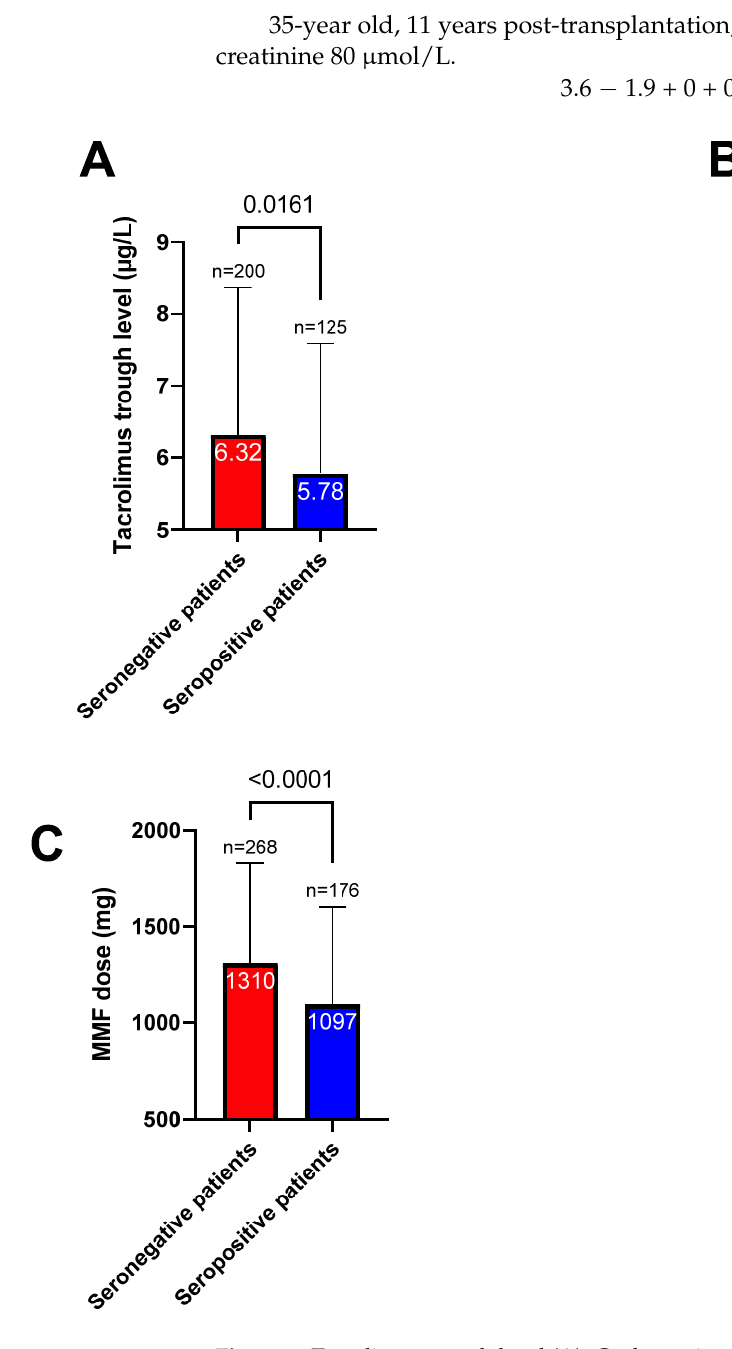
Figure 4. Tacrolimus trough level ( A ), Cyclosporine trough level ( B ), mycophenolate mofetil (MMF) dose ( C ), and steroid dose ( D ) according to the serological status after the second vaccine dose. Means are marked in white for each column; the number of patients and p values ( χ 2 test) are also reported.